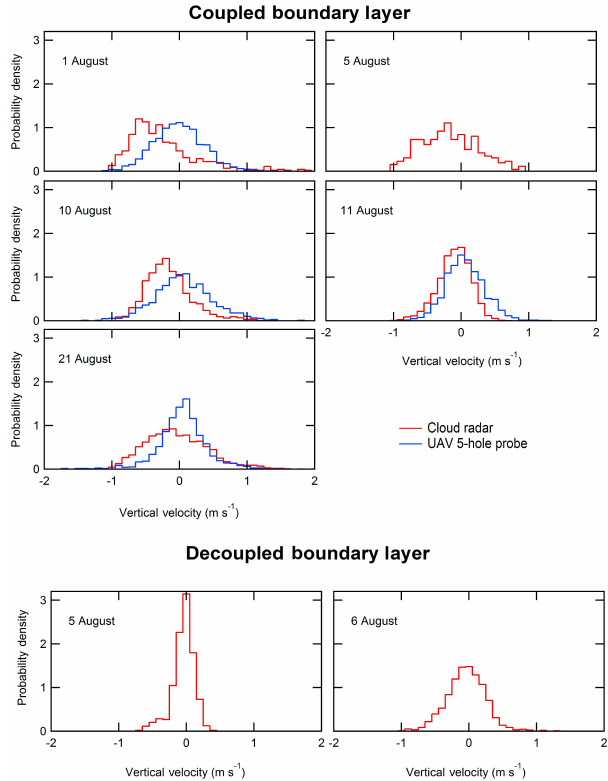
Figure 3. Normalized observed vertical velocity distributions mea- sured by the cloud radar and UAV for each case presented in Table